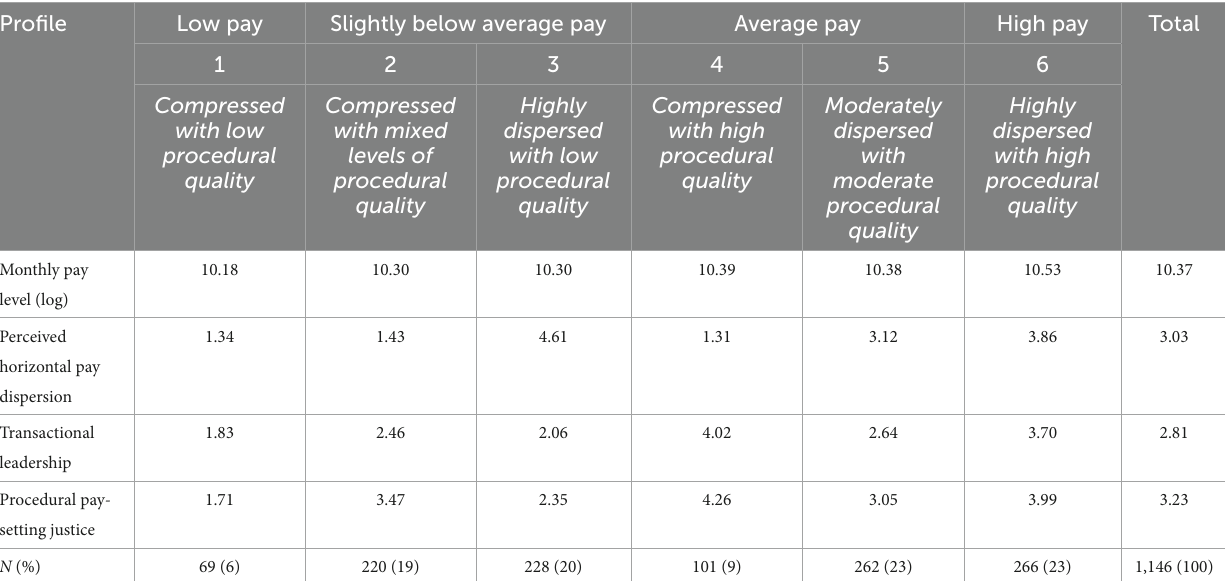
TABLE 3 Mean levels of the input variables for the six latent